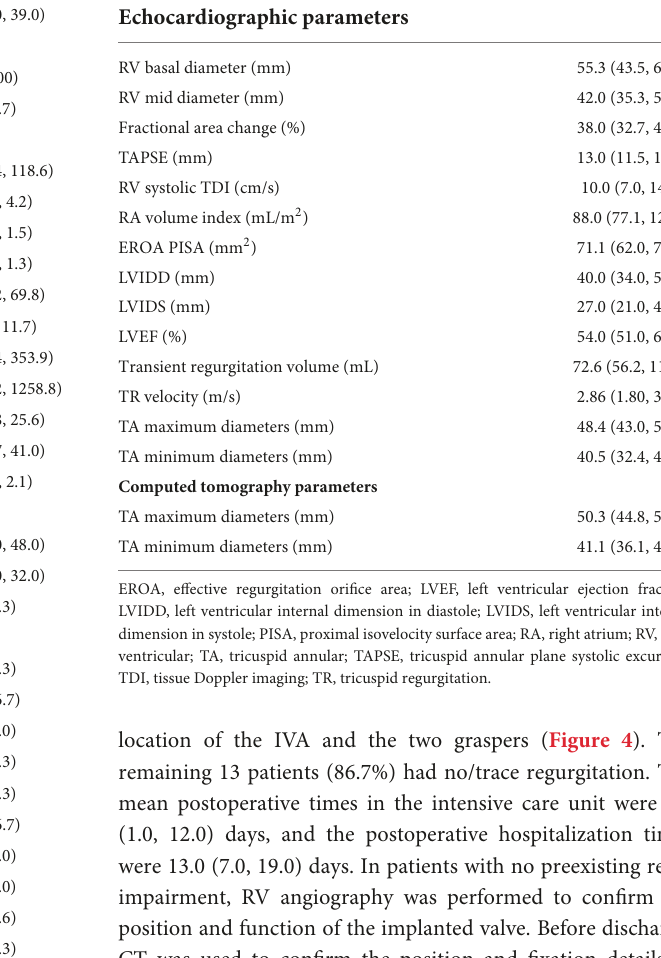
TABLE 2 Baseline echocardiographic and computed tomography parameters ( N =